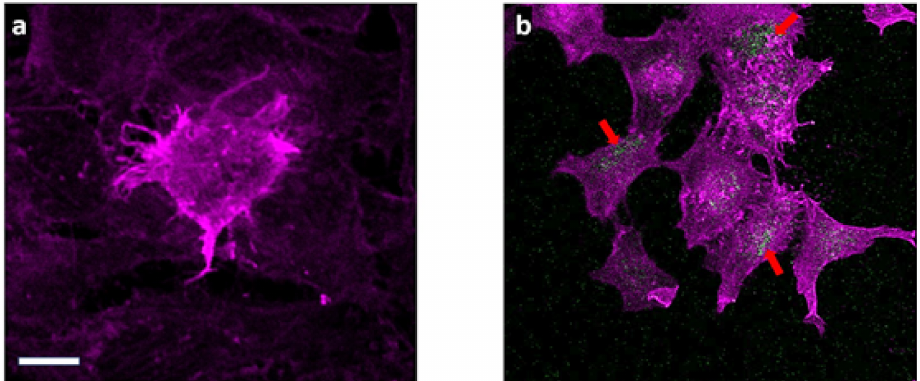
Figure 6. CLSM images of: ( a ) mock (untreated cells); ( b ) HeLa cells after 24 h of incubation with D-g-PNIPAM + Dox (25 + 1 µ g mL − 1 ). Arrows indicate the accumulation of nanoparticles inside cancer cells. actin staining (magenta), and particles (green). Scale bar 10 µ m (for both